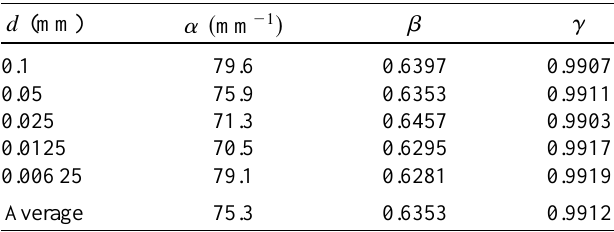
TABLE III. Fitting constants a , b , and g [see Eq. (3)] for random multipoles generated by random block displacements for the five-block coil of the main LHC